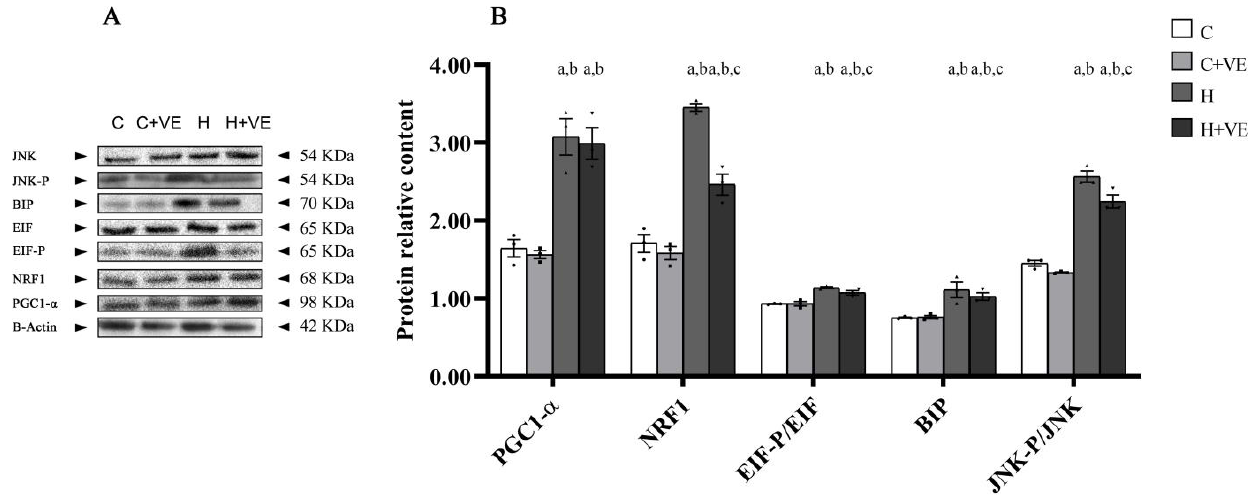
Figure 6. Oxidative stress sensitive factors involved in mitochondrial biogenesis (PGC1- α and NRF1) and cellular stress response (EIF, BIP JNK).A, representative Western blot images of PGC1- α , NRF1, EIF-P, EIF, BIP, JNK-P, JNK and β -Actin; B, muscle content of PGC1- α , NRF1, BIP and EIF-P/EIF and JNK-P/JNK ratio. C control rats; C + VE, vitamin-E-fed rats; H hyperthyroid rats; H + VE hyperthyroid and vitamin-E-fed rats. Values are the means ± SEM of three different rats. p < 0.05 was chosen as the significance level. Meaning of the letters: a, p < 0.05 vs. C; b , p < 0.05 vs. C + VE; c. p < 0.05 vs. H (one-way ANOVA followed by Tukey post-test).